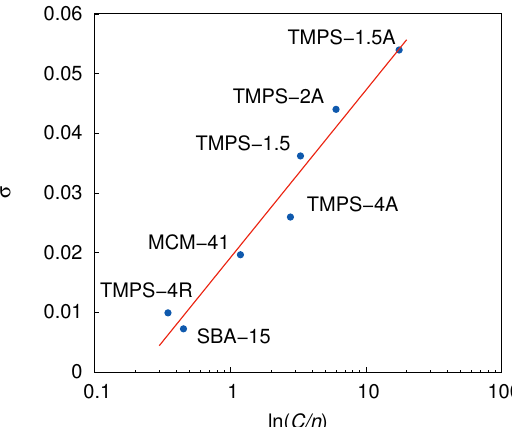
Figure 11. σ as function of a natural logarithm of the ratio of C over n . Solid line represents the linear